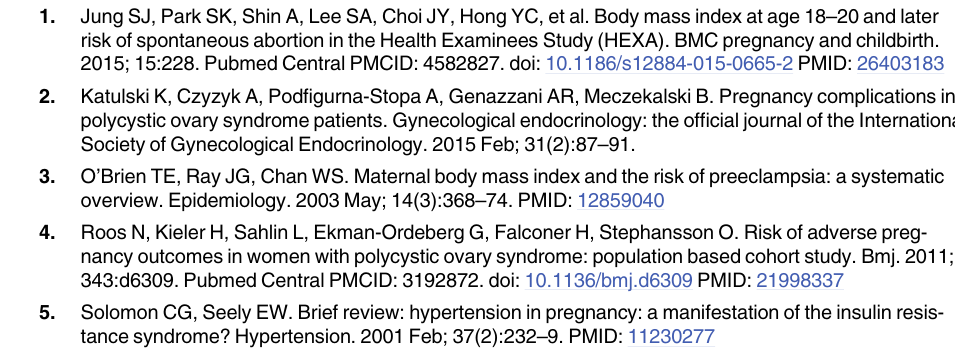
S1 Table. TaqMan assay applied in Real-Time PCR. TaqMan assays applied for amplification of prolactin ( PRL ), insulin-like growth factor binding protein-1 ( IGFBP1 ) and insulin receptor ( INSR ). RPL13A was used as an endogenous control. S2 Table. Oligonucleotides applied in Real-Time PCR. Forward and reverse oligos applied for amplification of connective tissue growth factor ( CTGF ), decorin ( DCN ) and left-right determination factor 2 ( LEFTY2 ). RPL13A was used as an endogenous